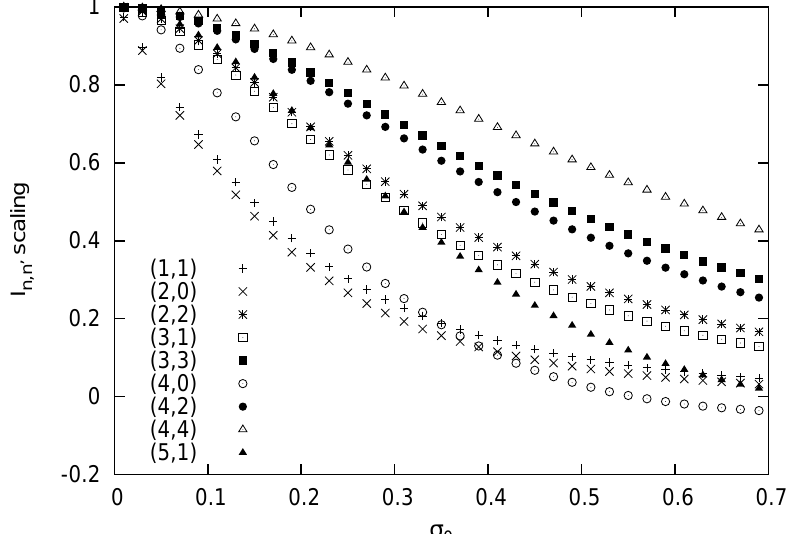
Fig. 1. The unitless factor (22) as a function of the unitless outer scale param- eter (cid:27) 0 for some index pairs ( n; n ′